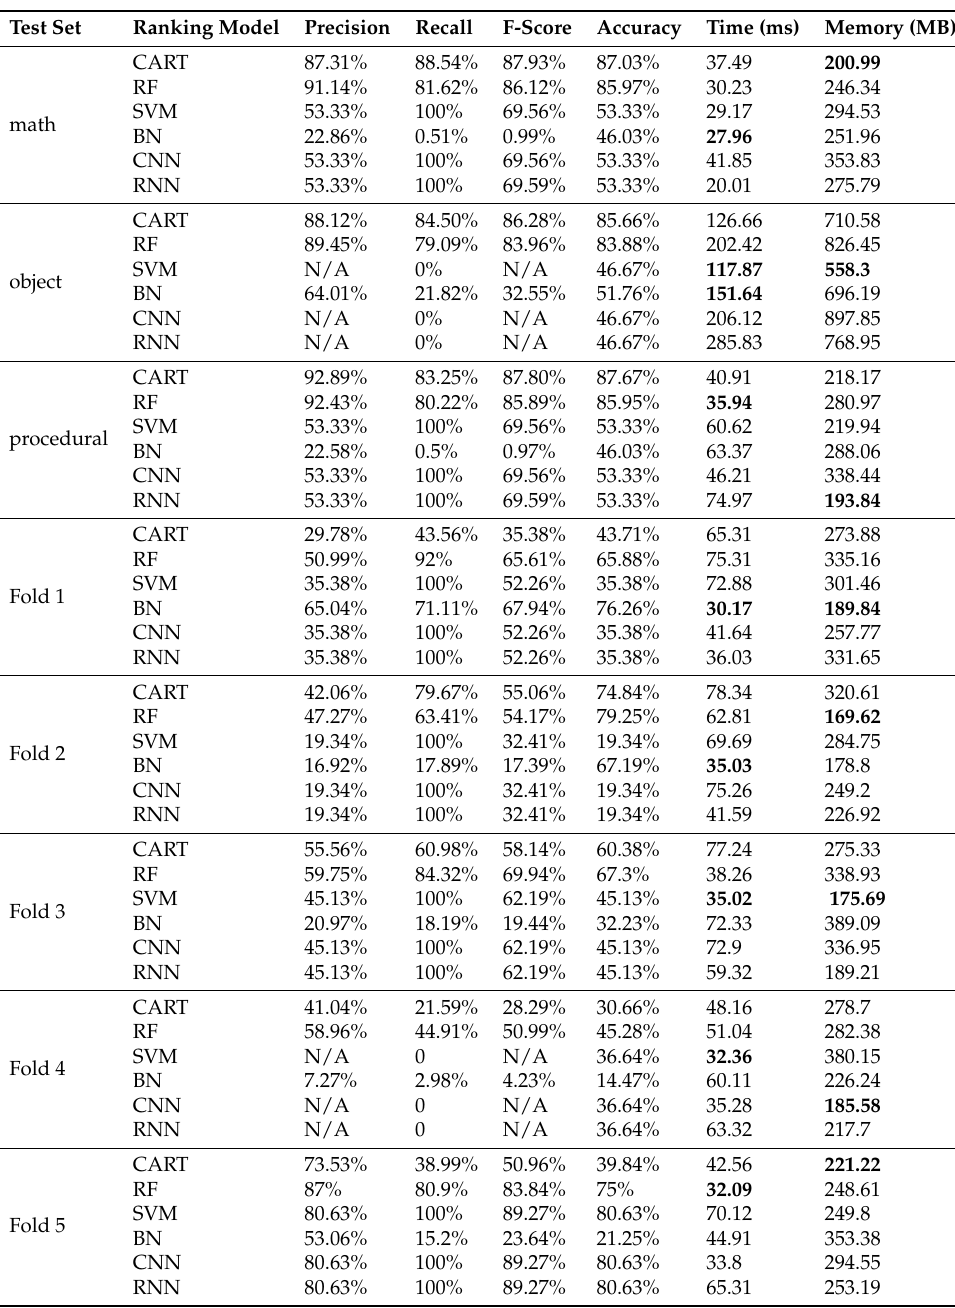
Table 4. Results of six ranking models under six evaluation metrics. Precision is the proportion of returned results that are truly correct; Recall is the proportion of the truly correct results in all retrieved results from the test set; F - score is the trade-off between Precision and Recall ; Accuracy is the proportion of correct results in all results from the whole data set; Time is the time consumption on the test set; and Memory is the memory consumption on the test set. N/A indicates the denominator is